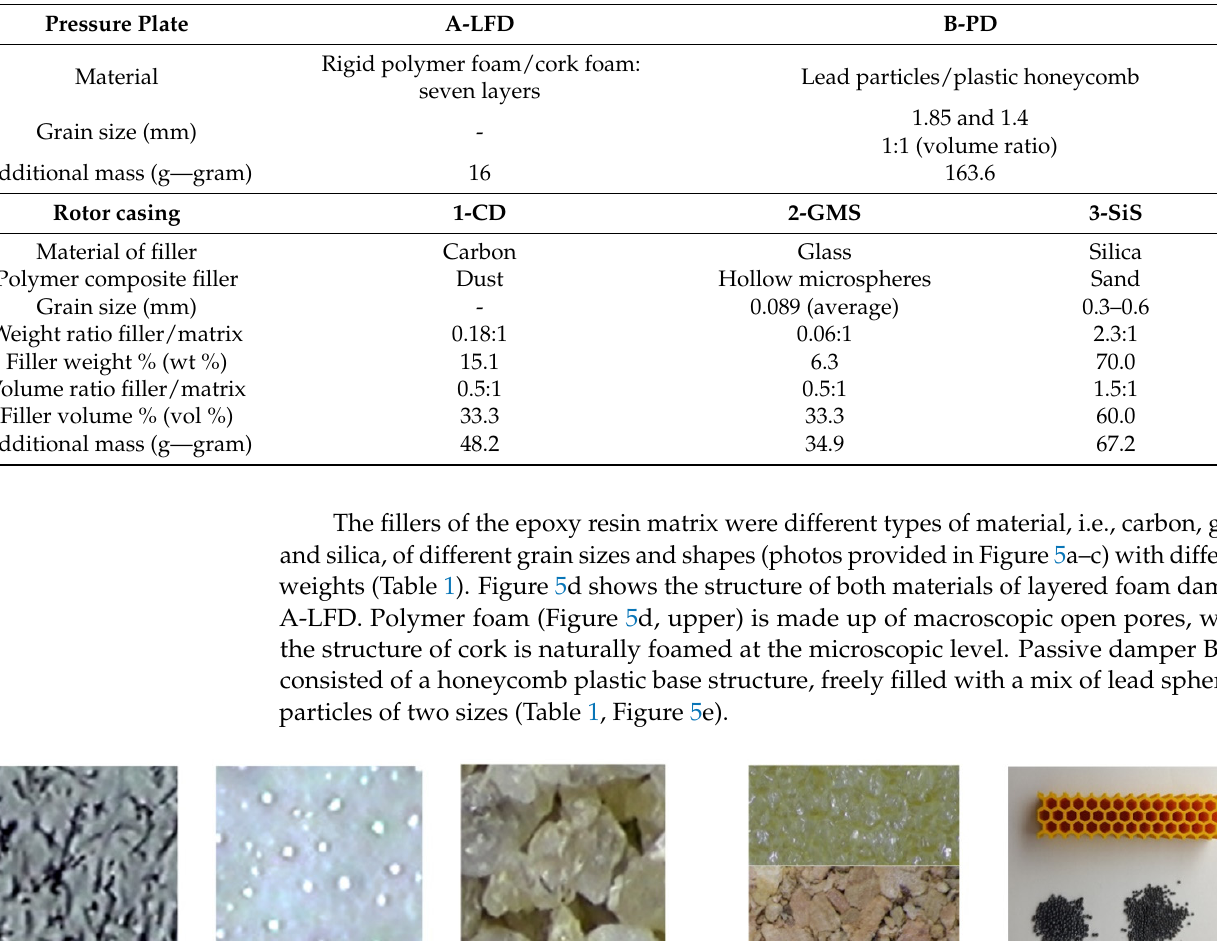
Table 1. Parameters of additional materials.